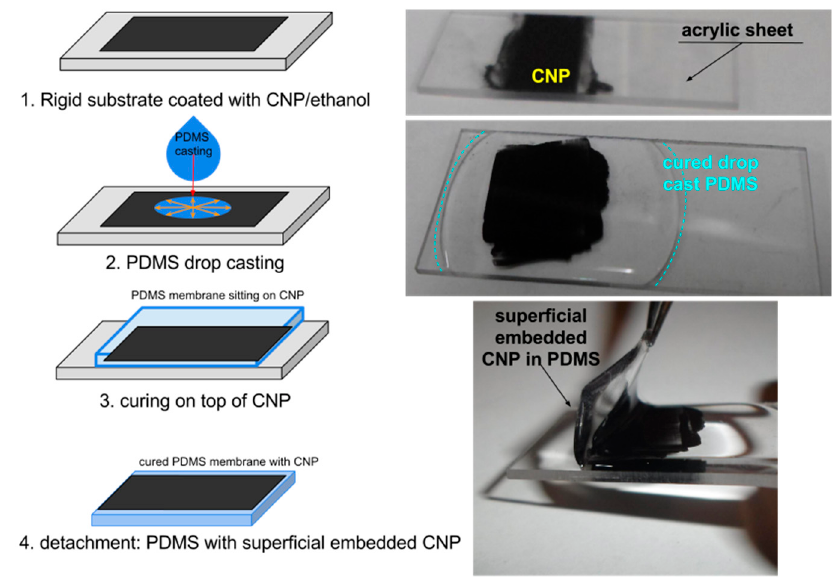
Figure 9. Adapted preparation method for superficially embedded CNPs in PDMS membranes.